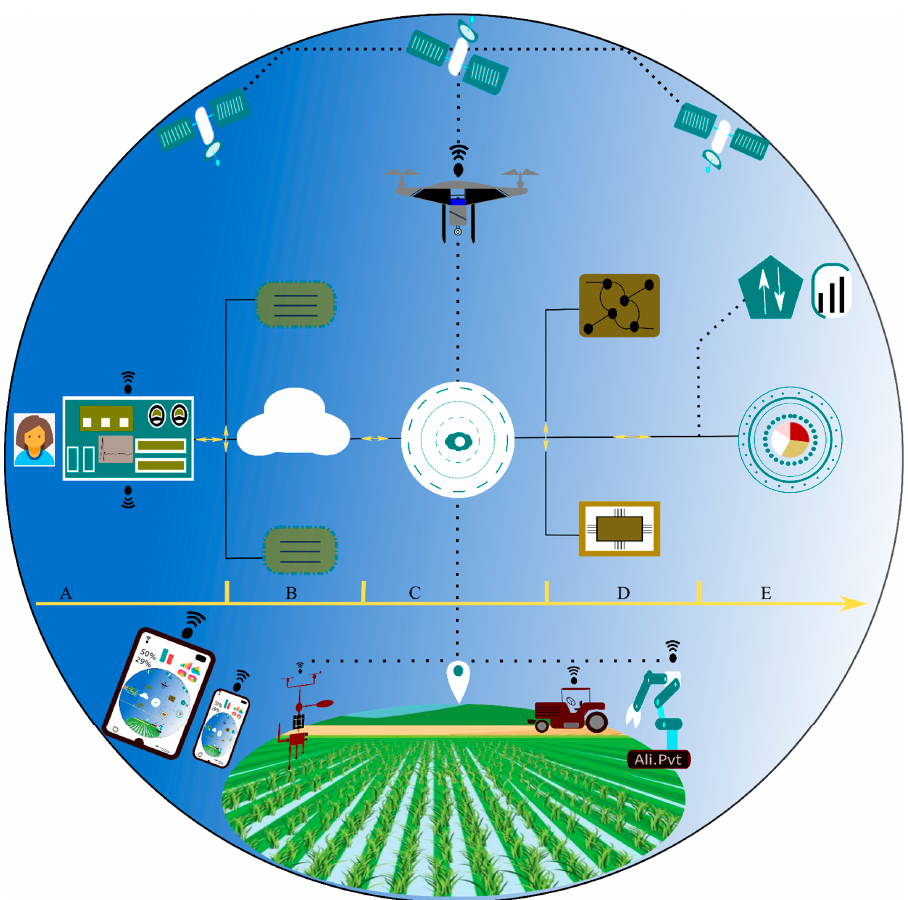
Figure 9. An anticipated model of remote sensing (RS) technologies applied to agriculture in the 5th industrial revolution. The figure can be read from left to right, where ( A ) represents the user control center, ( B ) represent servers, cloud and the related storage accessories, ( C ) represents the real players, e.g., satellites, remotely piloted aircrafts (RPAs), autonomous robots, metrological stations, etc., for data acquisition, ( D ) represent data processing using machine learning and related platforms that ultimately produce infographics and other useful information in ( E ).